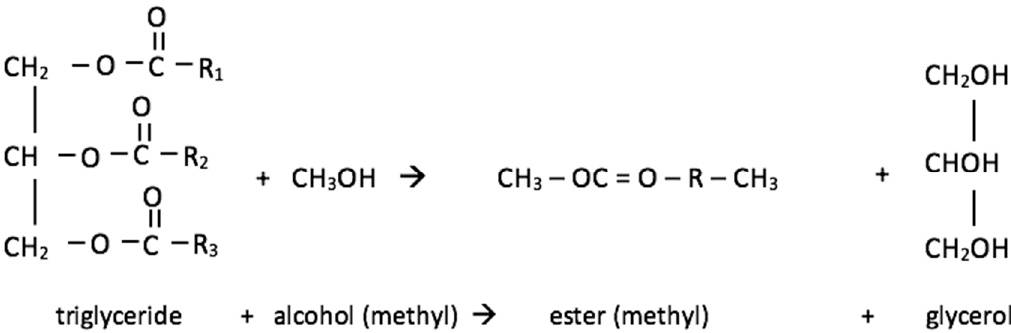
Figure 7. Transesterification process.